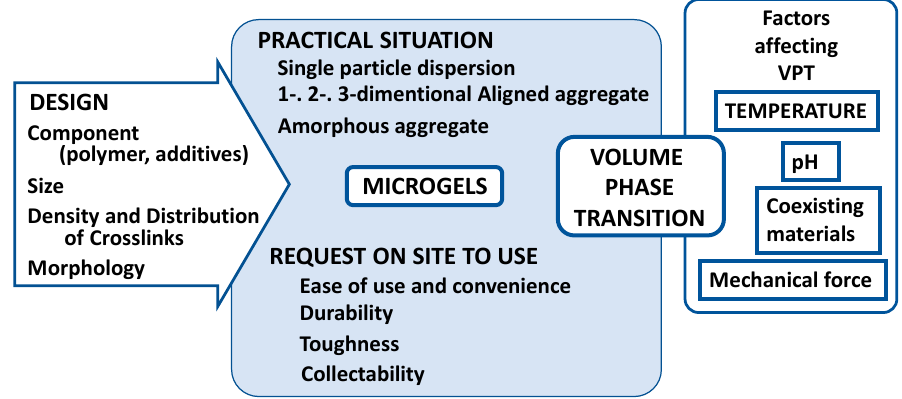
Figure 10. Items to be considered from synthesis to application of practical microgels.